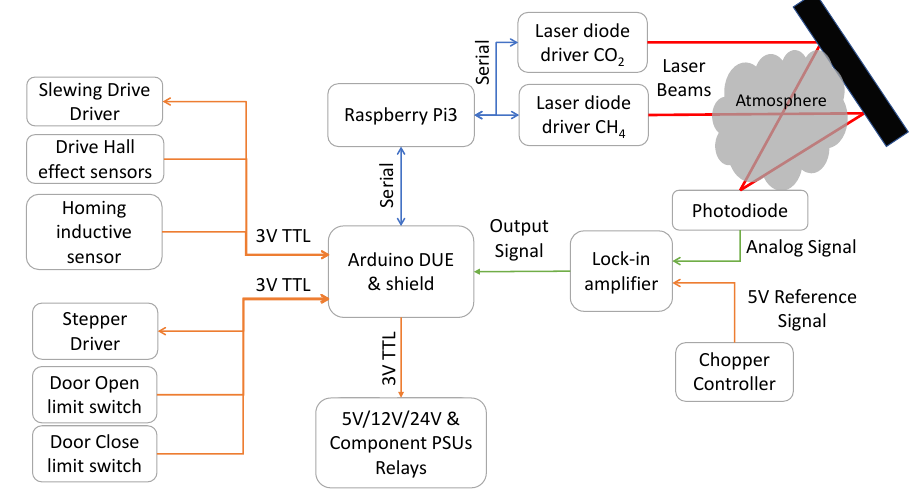
Figure 4. Device control diagram.